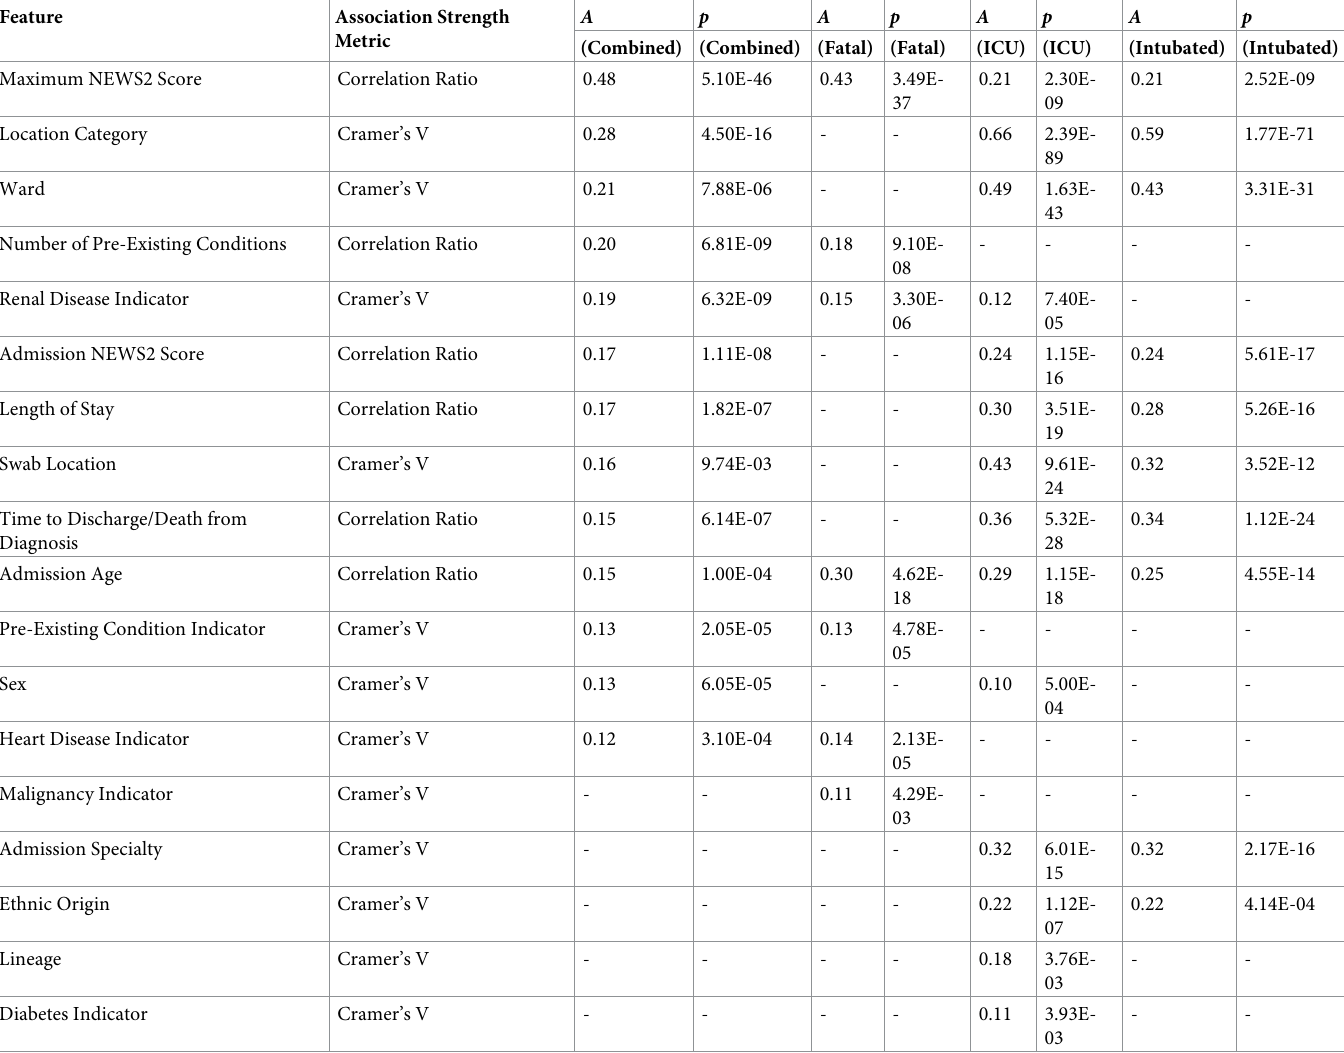
Table 2. Association between clinical variables and disease severity.